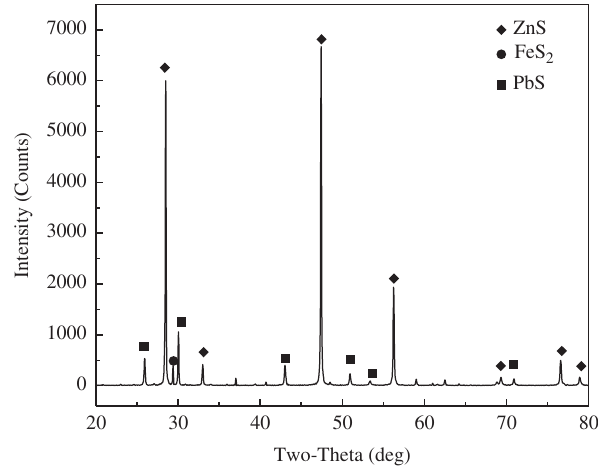
Figure 1: XRD pattern of zinc sulfide